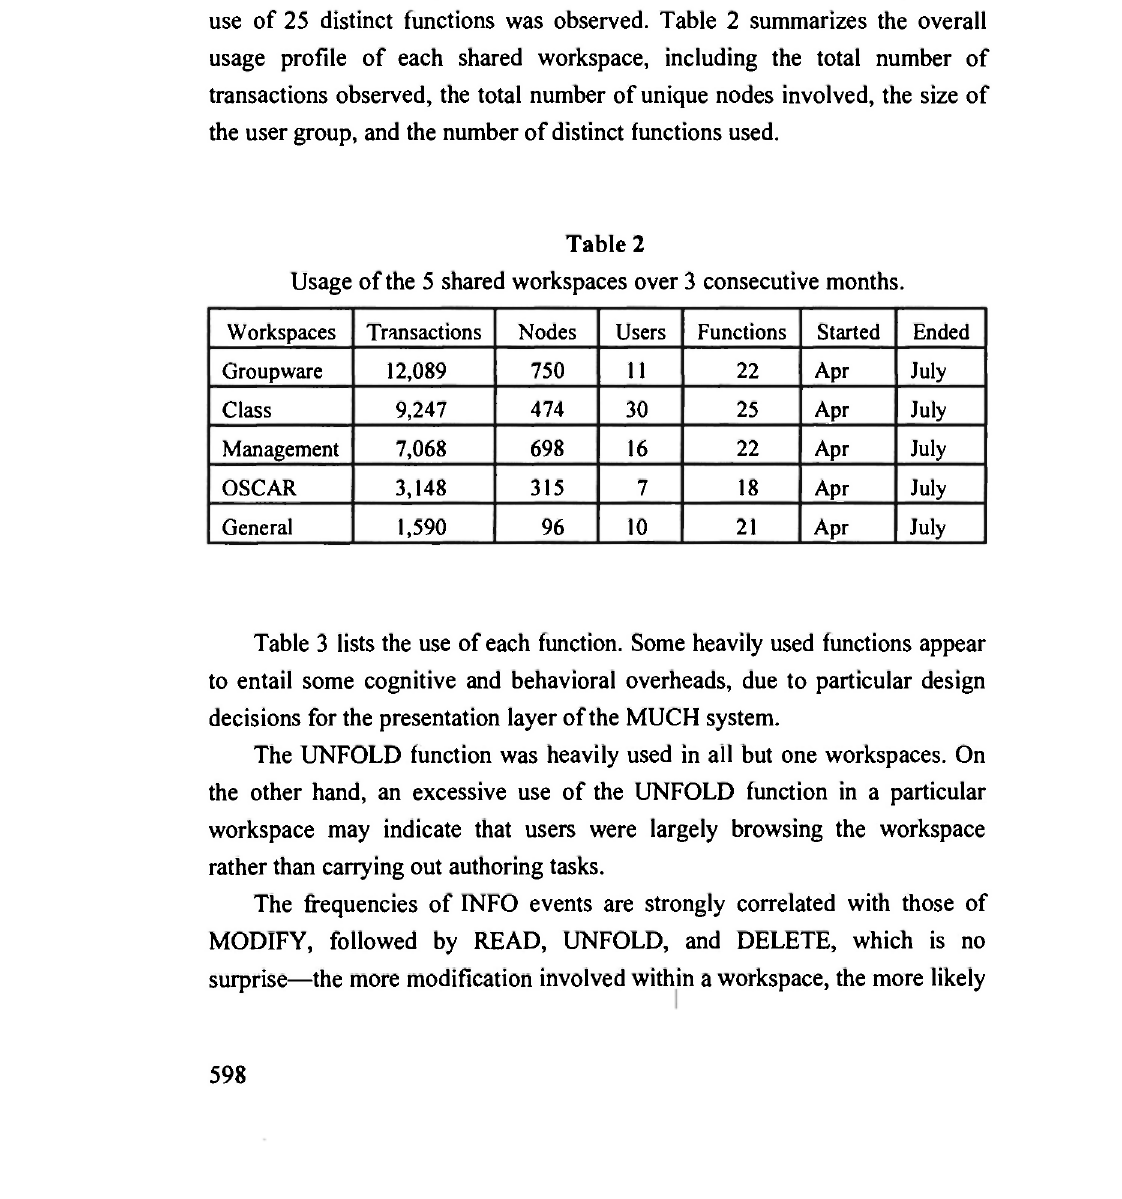
Usage of the 5 shared workspaces over 3 consecutive